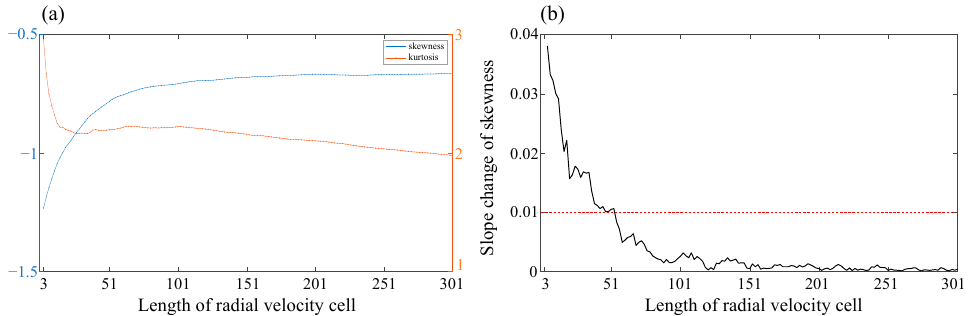
Figure 7. Test of selecting the best 2D MA filter: ( a ) Skewness and kurtosis of the histogram of the residual series for various moving window sizes; ( b ) Slope changes in the skewness curve and the convergence condition setting.